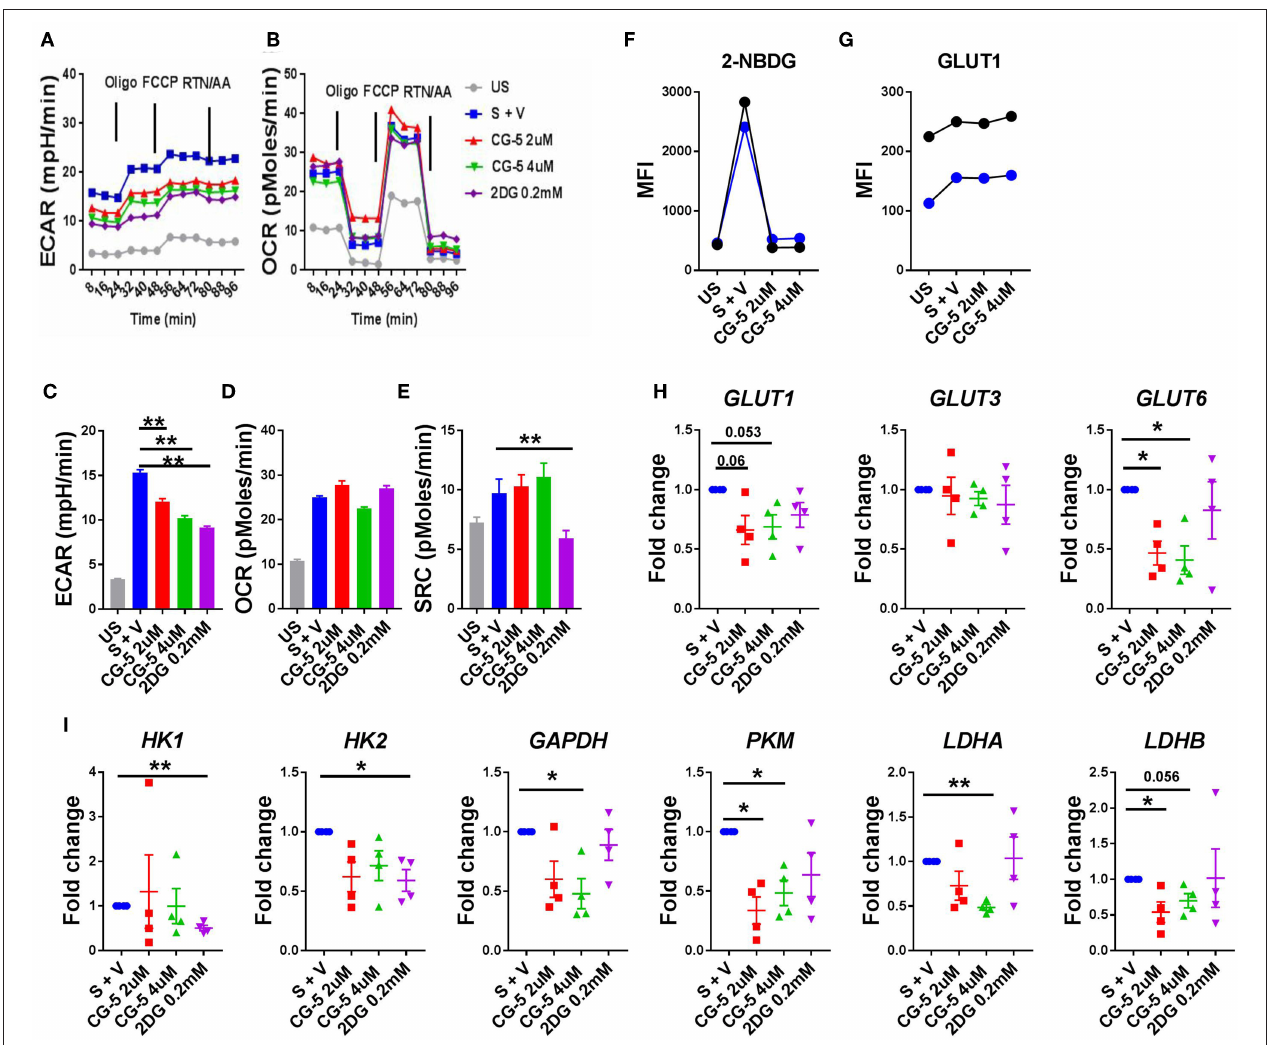
FIGURE 7 | CG-5 blocks glycolysis in human CD4 + T cells. ECAR (A) and OCR (B) were measured in human CD4 + T cells, either unstimulated (US) or stimulated with anti-CD3/CD28 mAbs (S) for 24h in the presence of vehicle (V), 2 or 4 µ M CG-5, or 0.2mM 2DG. Quantification of basal ECAR (C) , OCR (D) and SRC (E). 2-NBDG uptake (F) and GLUT1 protein expression (G) in stimulated human CD4 + T cells ( n = 2) for 24h in the presence of 2 or 4 µ M CG-5. (H,I) Expression of glycolytic genes normalized to vehicle-treated group. Mean ± S.E.M. of n = 4 per group compared with S + V values using one-way ANOVA. * p < 0.05; ** p <